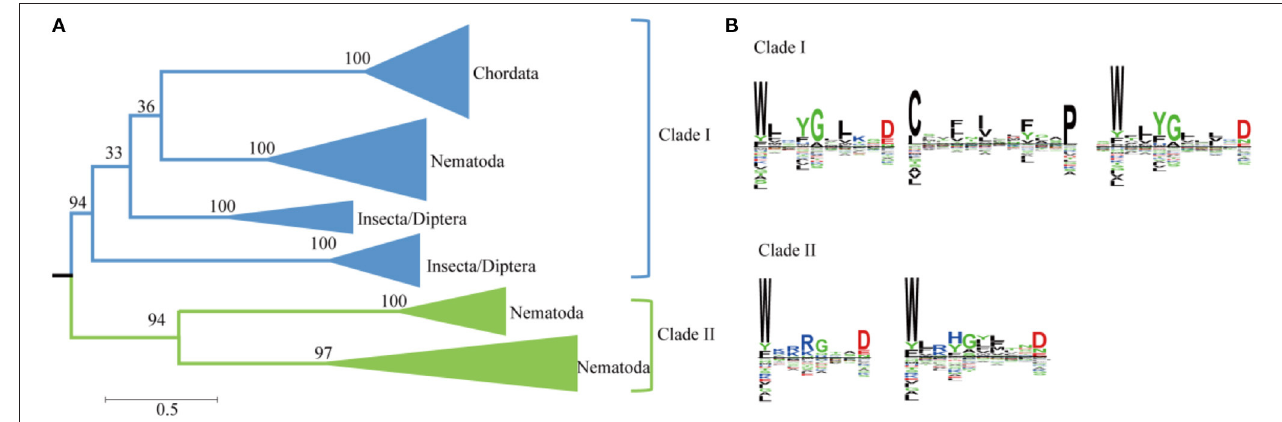
FIGURE 5 | Phylogenetic and conserved motif analyses of SWEETs from Metazoa. (A) Molecular phylogenetic analysis by the maximum likelihood method. The tree with the highest log likelihood ( − 35684.4811) is shown. The tree is drawn to scale, with branch lengths indicating the number of substitutions per site. Evolutionary analyses were conducted in MEGA7. (B) Sequence alignment of conserved motifs of SWEETs in different clades corresponding to (A) . The sequences were aligned by ClustalW. The conservation level of each residue is indicated by the height of the bar above it. The sequence logo was generated using Seq2Logo.